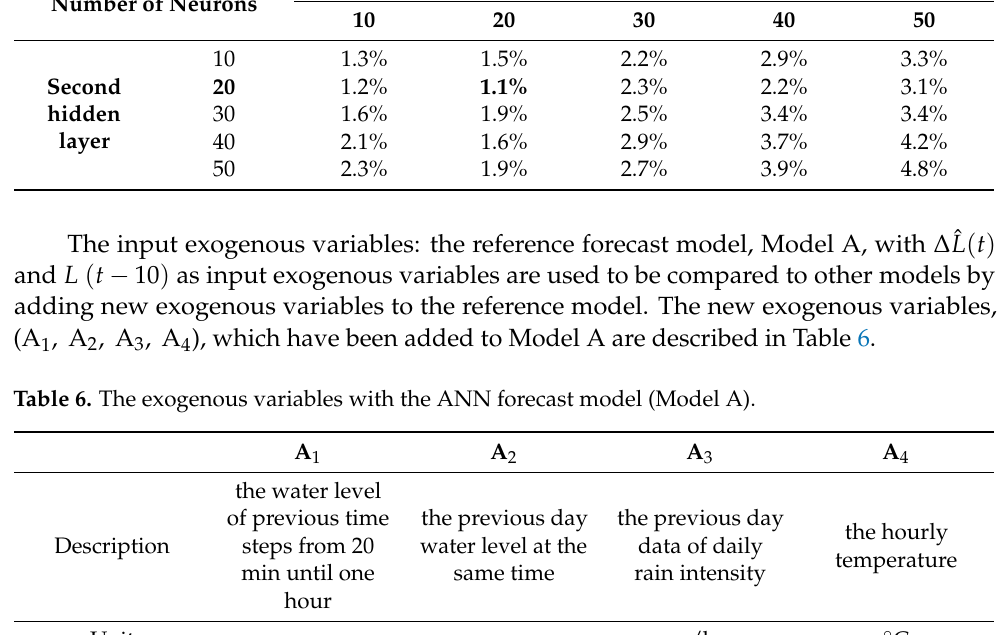
Table 5. The mean of the daily MAPE values for Model A with different numbers of neurons. Number of Neurons